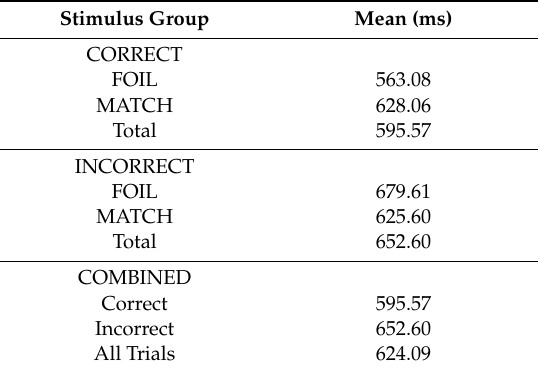
Table 4. E ff ect of Response Strategy on Reaction Times for the Simulated Malingering Condition in Experiment 2 ( N = 15) grouped by